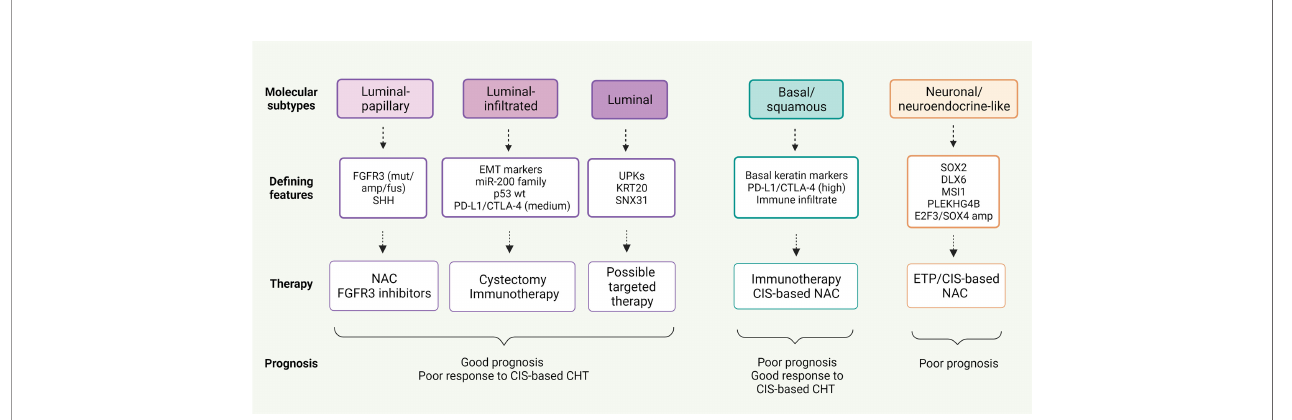
FIGURE 2 | Correlation between fi ve mRNA-based expression subtypes according to The Cancer Genome Atlas (TCGA) analysis and response to neoadjuvant therapy